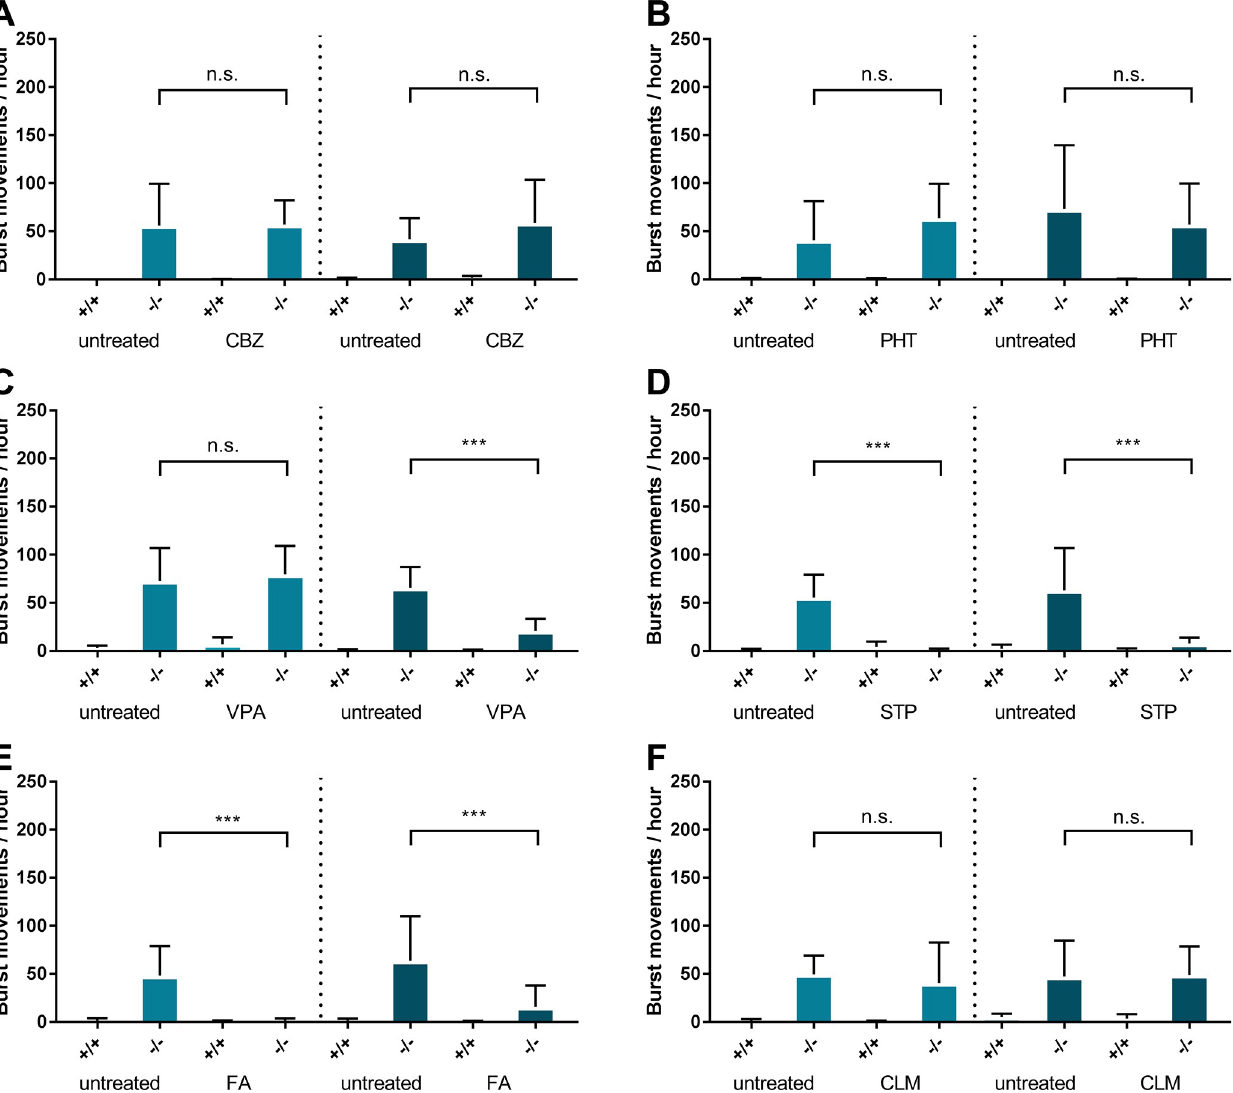
Fig 3. Pharmacologic validation of Scn1Lab knockouts by 60 minutes (light blue) or 18 hours (dark blue) exposure of anti-epileptic drugs A) 50 μ M Carbamazepine B) 100 μ M Phenytoin C) 100 μ M Sodium valproate D) 12.5 μ M Stiripentol E) 50 μ M Fenfluramine F) 50 μ M Clemizole. Dashed lines indicate a novel experimental plate with a seperate experimental group. Error bars = S . D ., (-/-) = Scn1Lab knockout , n = 12 per group � < 0 . 05 �� < 0 . 005 ��� < 0 . 0005 .